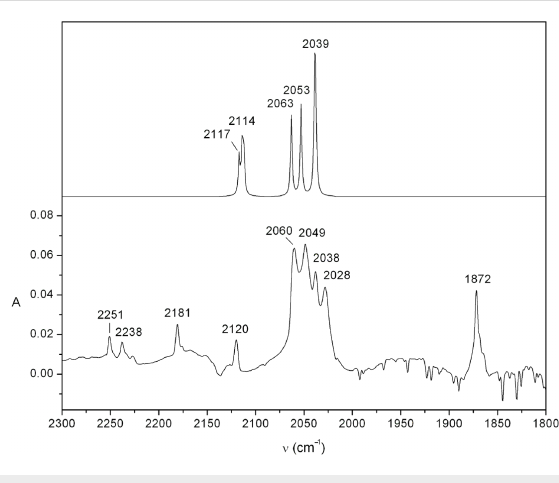
Figure 4: Bottom: IR spectrum from the matrix photolysis of azide 18 after the azide has been depleted completely (10 min broadband UV, followed by 30 min low pressure Hg lamp at 254 nm). Top: the calcu- lated absorptions of the four isomers of the open chain ketenimine 27 (1:1:1:1 ratio of the s- E , E ; s- E , Z ; s- Z , E ; and s- Z , Z isomers). The calcu- lated peak at 2039 cm − 1 is due to the overlapping peaks of